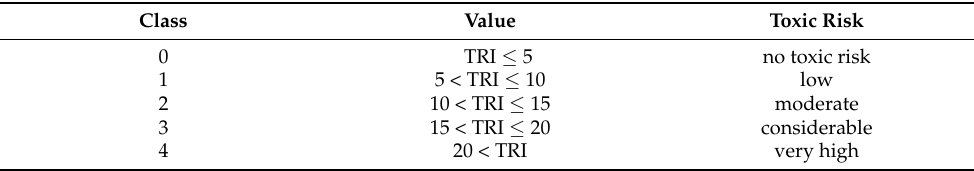
Table 4. Toxic Risk Index (TRI) classification.